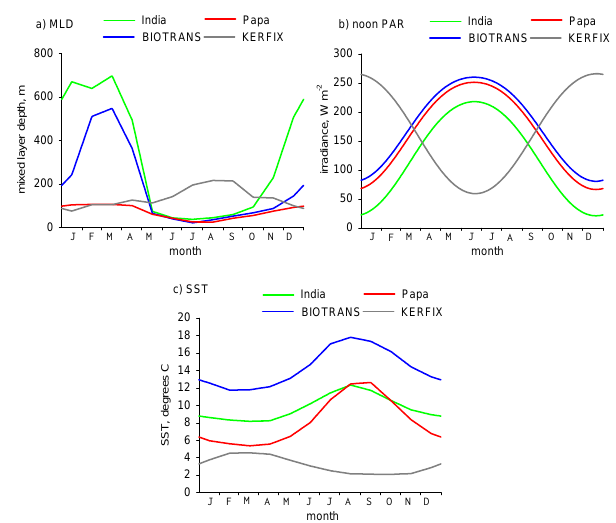
Figure 3. Model forcing for stations India (60 ◦ N, 20 ◦ W), BIO- TRANS (47 ◦ N, 20 ◦ W), Papa (50 ◦ N, 145 ◦ W) and KERFIX (50 ◦ 40 (cid:48) S, 68 ◦ 25 (cid:48) E): (a) mixed layer depth (m), (b) noon irradi- ance (Wm − 2 ) , (c) sea surface temperature ( ◦ C).